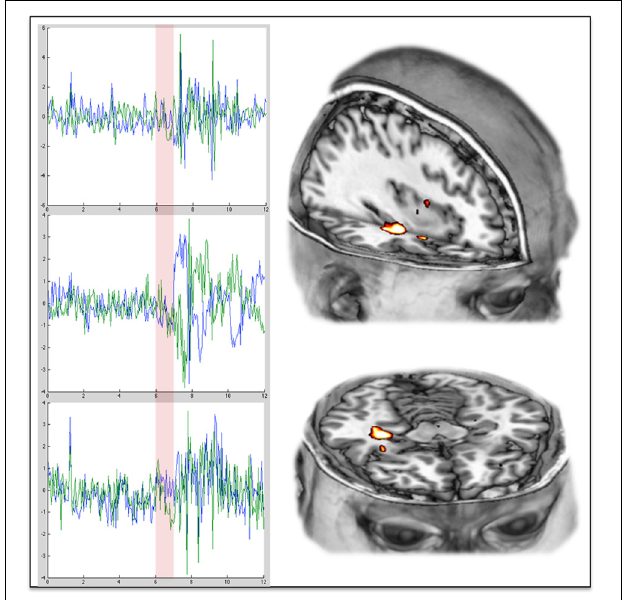
FIGURE 3 | Increased variance/amplitude fluctuations in the hippocampus post-psilocybin. The charts on the left show the complete time series from the hippocampus ( left in blue, right in green) in 3 different individual subjects during the 12min scan in which they received psilocybin. The transparent red vertical line indicates the beginning and duration of the 60s infusion of psilocybin. The images on the right show the right hippocampal region where the increases in variance were especially